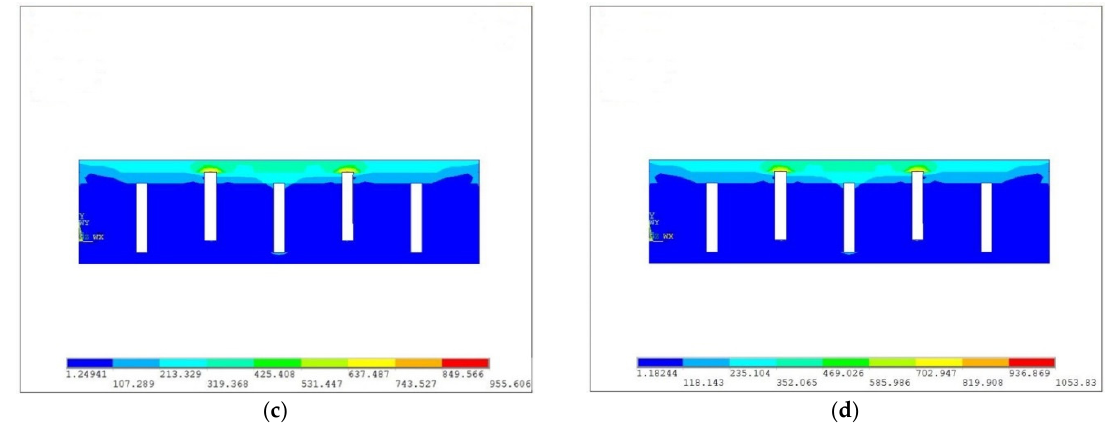
Figure 7. The thermal stress distribution on F1 cross ‐ section at different heating powers and different heating uniformities (Unit: MPa). ( a ) P = 13.23 W U f = 100%; ( b ) P = 13.23 W U f = 50%; ( c ) P = 13.23 W U f = 30%; ( d ) P = 13.23 W U f = 10%.